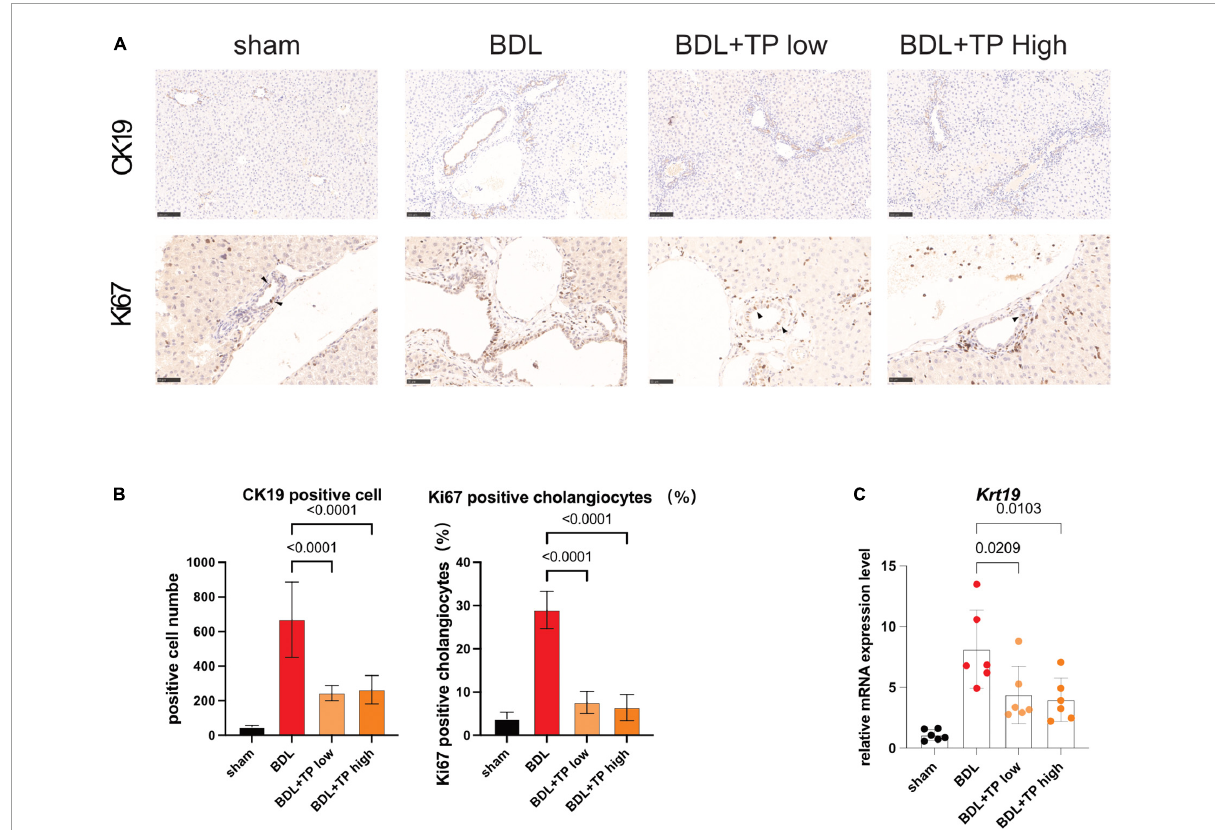
FIGURE4 Triptolide relieves BDL-induced bile duct hyperplasia. (A) Representative images of IHC for CK19 and Ki67 (The black arrows indicate the regenerated cholangiocytes) from liver tissues. Scale Bar: 100 µ m. (B) Statistical analysis of immunohistochemically positive regions of (A) . (C) The mRNA level of Ck19 in liver tissues. Data are shown as the mean ± SD. Data represent at least 6 independent experiments with triplicate measurements. Analysis of variance (one-way ANOVA) was used. p values represents significance different from BDL group.